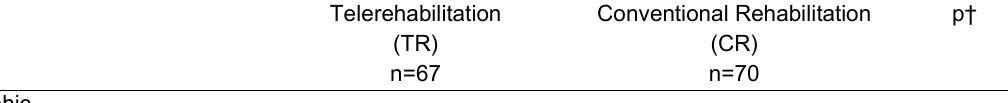
Baseline Characteristics for the Telerehabilitation and the Conventional Rehabilitation Group